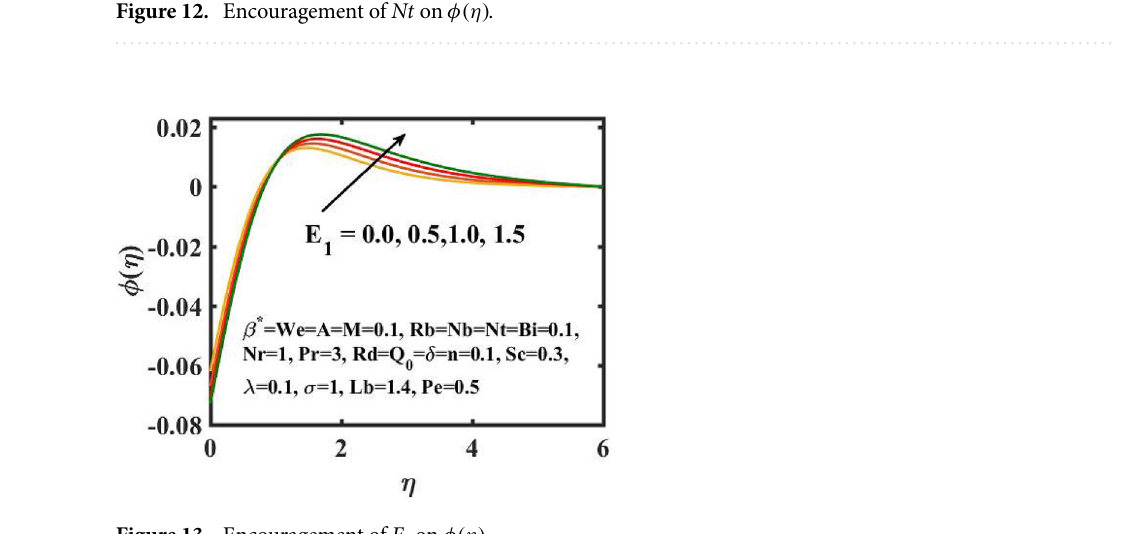
Figure 13. Encouragement of E 1 on φ(η) .